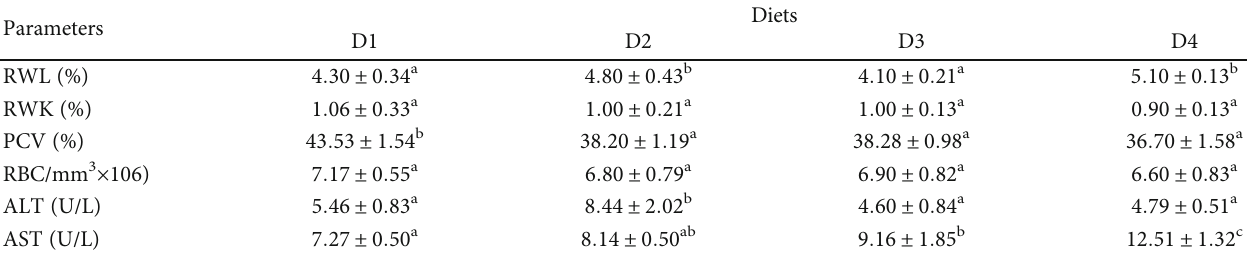
Table 4: E ff ect of the di ff erent treated diets on the biological parameters and serum enzyme activities of rats. Parameters